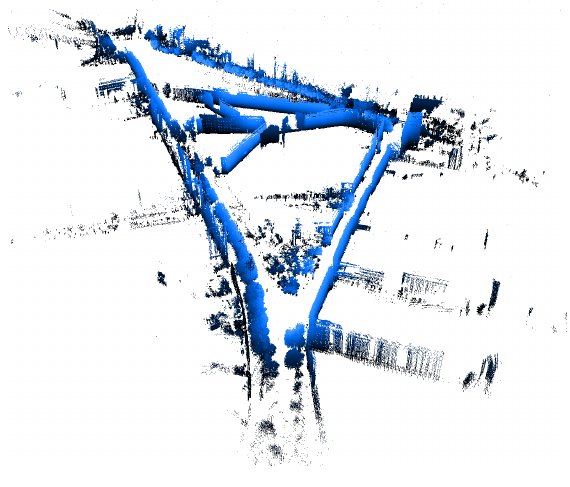
Figure 1: Dataset.